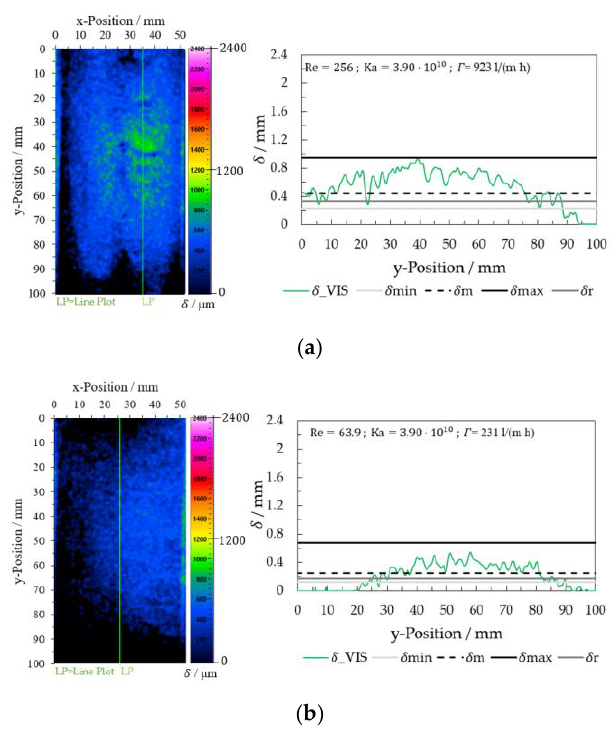
Figure 12. Film thickness determination using VIS image analysis for the glycerol/water mixture 0.65 g glyc g total − 1 . ( a ) Re = 19.2 and ( b ) Re = 4.80. Illumination inhomogeneity affected the evaluation in the two ranges of the plate between y-Position = 0 and 20 mm and y-Position = 80 and 100 mm. Higher film thicknesses ( δ > 0.8 mm for ω g = 0.65 g glyc g total − 1 and Γ = 923 L/(m h)) show more stable results on